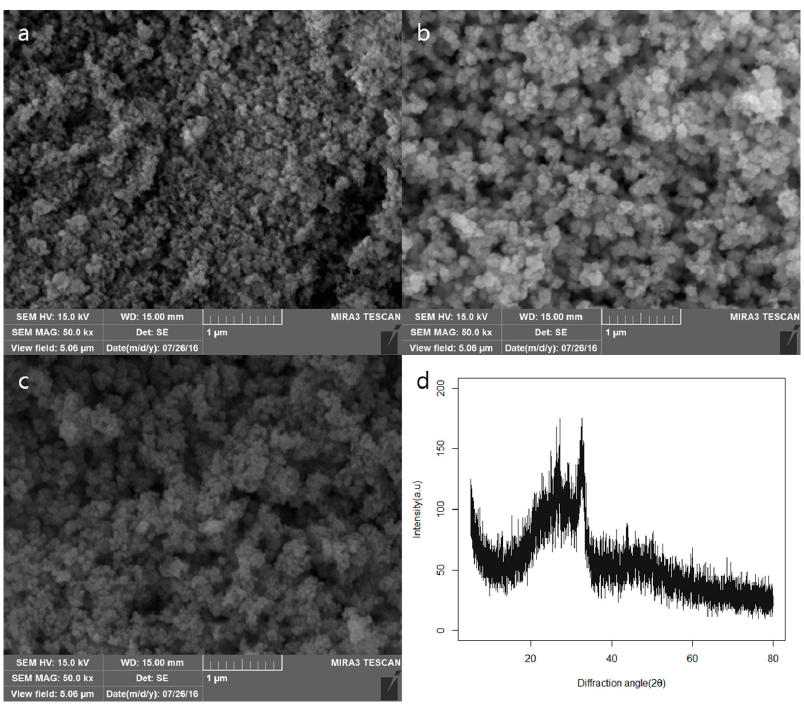
Figure 1. The SEM images of the ( a ) BAG; ( b ) BAG@Ag1 and ( c ) BAG@Zn5; ( d ) XRDpattern of BAG.